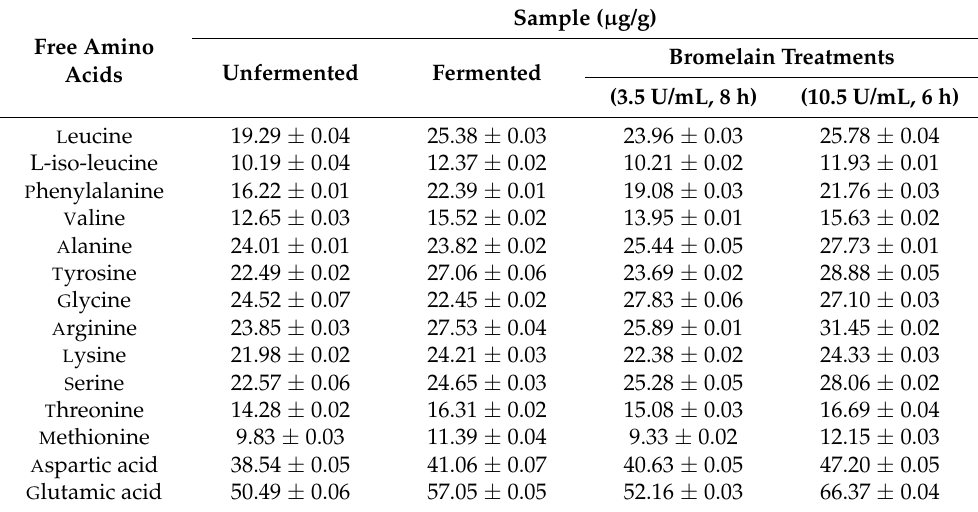
Table 3. Free amino acid of cocoa beans hydrolyzed by bromelain.